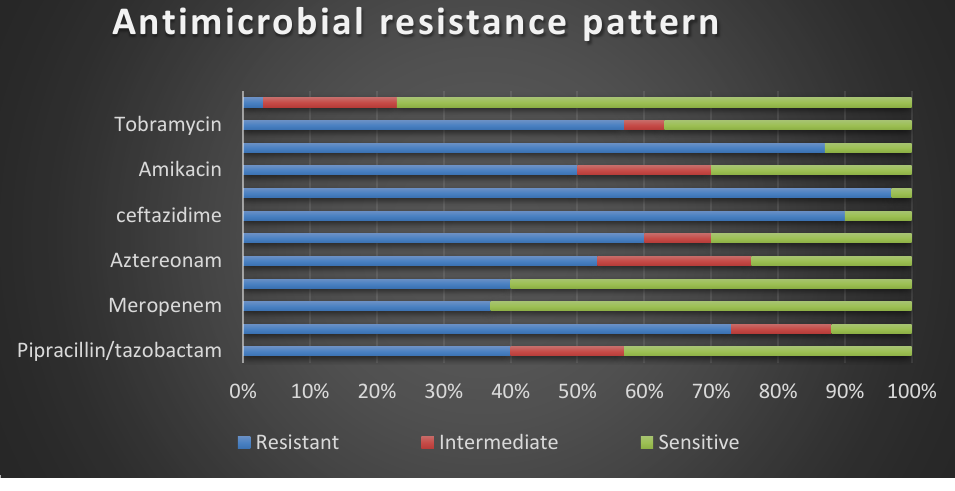
Figure 3. A plate of MacConkey agar showing non-lactose fermenting colonies of P. aeruginosa.